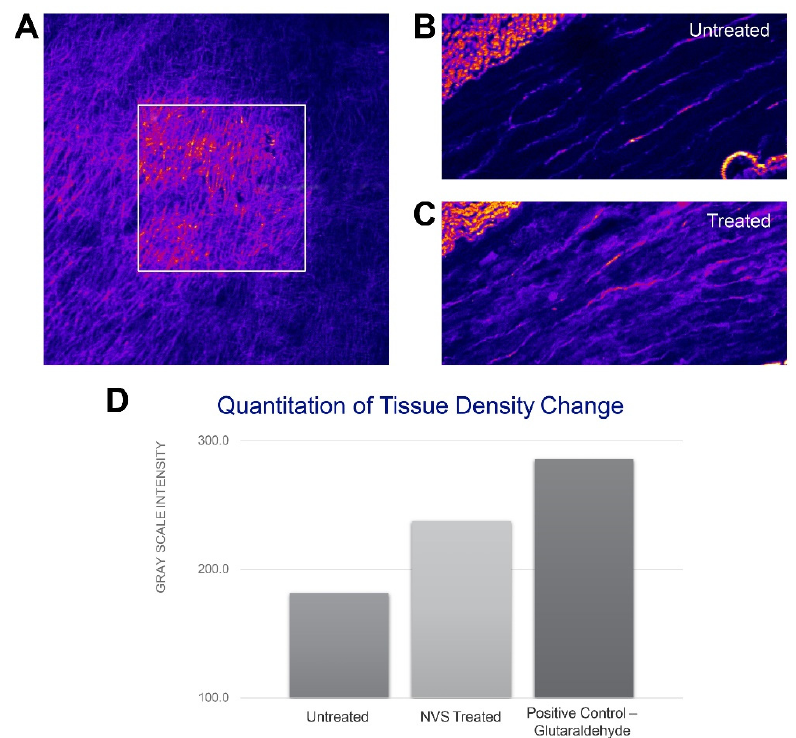
Figure 6. Visualization of NVS treatment effect on arterial wall segment by multiphoton microscopy imaging: ( A ) Second harmonic generation showing collagen change as a result of photoactivation (square area). Representative histological cross-sections of untreated ( B ) and NVS-treated tissue ( C ). ( D ) Quantitation of tissue density change as determined by gray scale intensity between untreated ( left bar), NVS- ( middle bar) and glutaraldehyde-treated ( right bar) tissue.